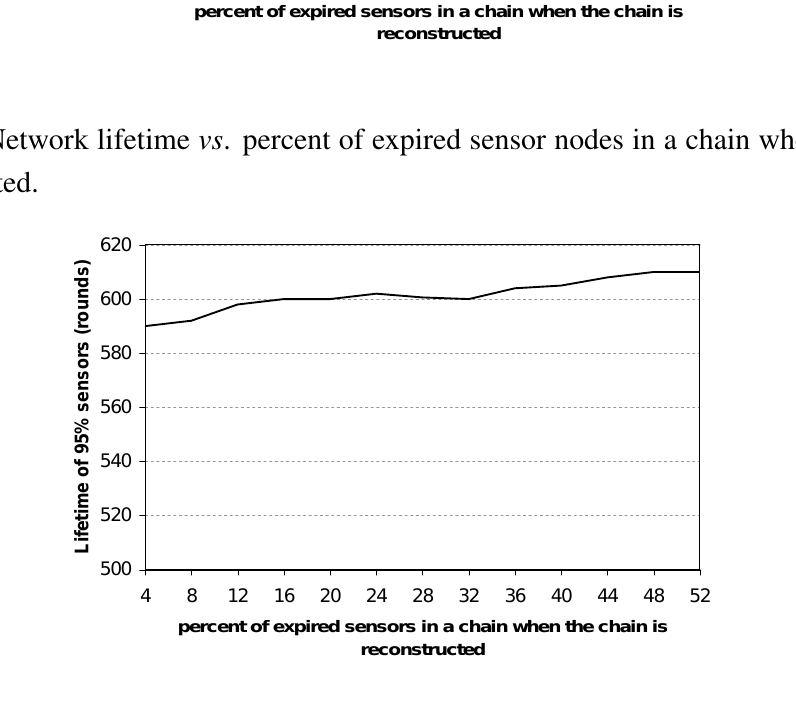
Figure 12. Time required vs . percent of expired sensor nodes in a chain when the chain is